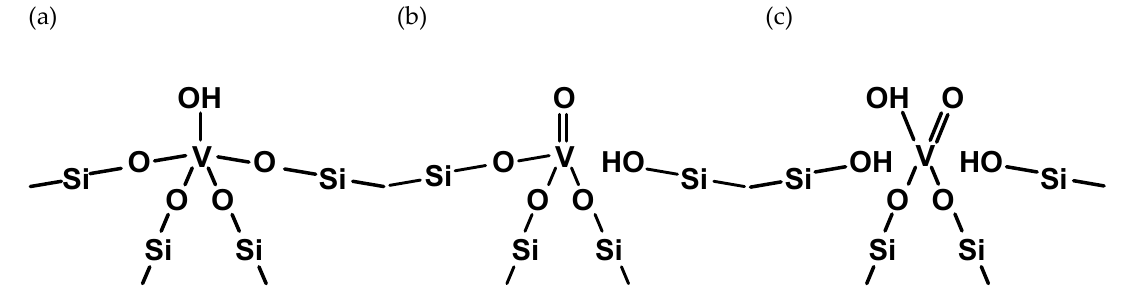
Figure 2. Three different forms of vanadium considered in the current work: ( a ) V–OH, ( b ) V=O, ( c ) Figure 2. Three di ff erent forms of vanadium considered in the current work: ( a ) V–OH, ( b ) V = O, V(=O)(–OH). ( c ) V( =